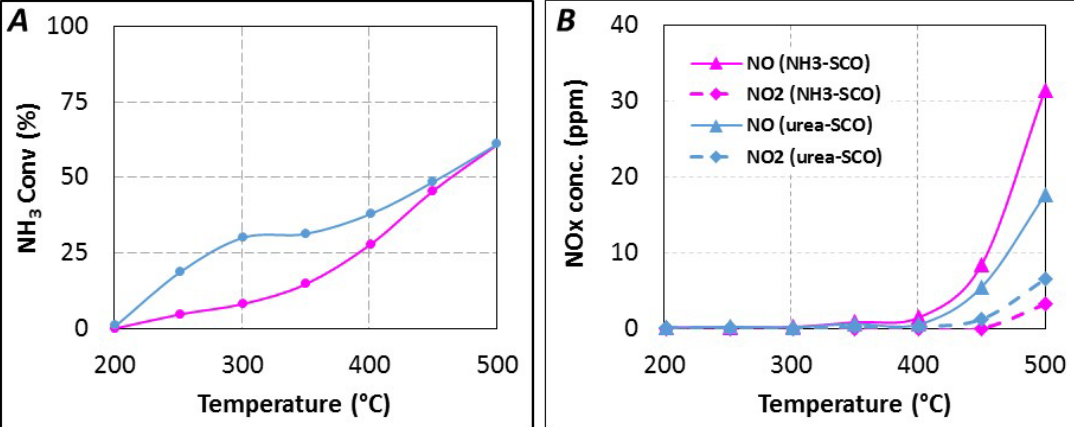
Figure 6. ( A ) urea-SCO (▬, t R = 4.0 s) and NH 3 -SCO (▬) for 400 ppm eq. NH 3 , 8% H 2 O, 10% CO 2 , 10% O 2 ; ( B ) NO x distribution in urea-SCO and NH 3